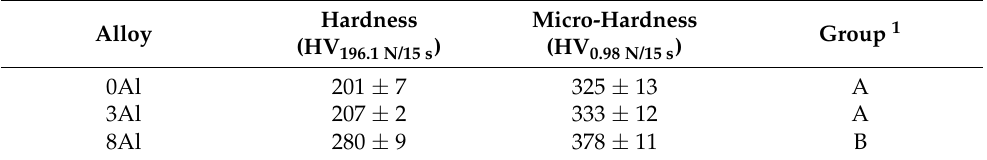
Table 4. Macro and micro-hardness of the